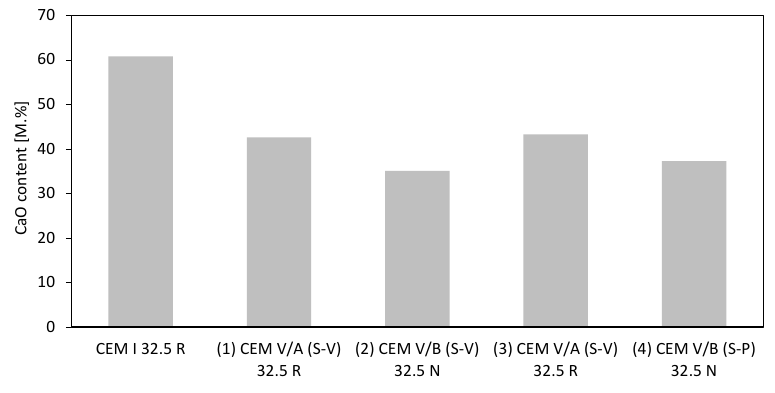
Figure 2. CaO content of the various CEM V cement types.